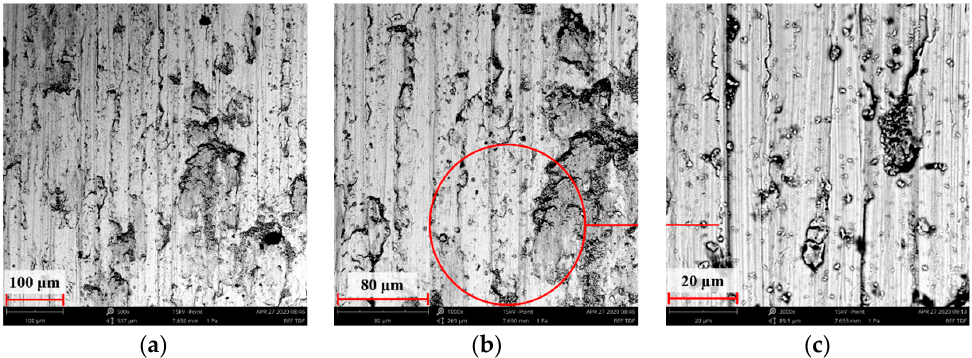
Figure 20. SEM image of the steel 316L wear track after dry sliding: ( a ) ×500, ( b ) ×1000, ( c ) ×3000.